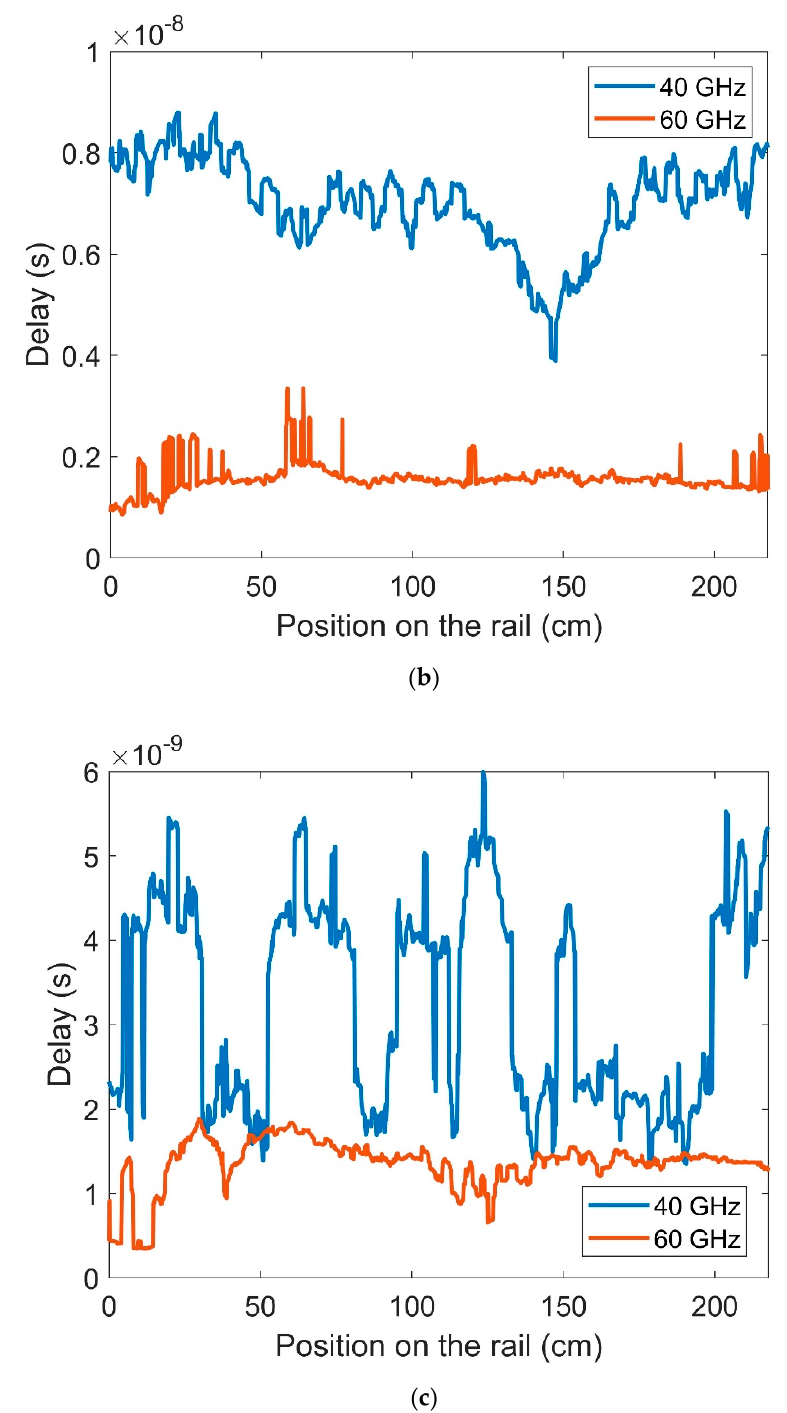
Figure 11. RMS delay at the auditorium, at both considered bands, moving the receiver along the central corridor: ( a ) Received by antenna 2; ( b ) by antenna 3; ( c ) by antenna 4.